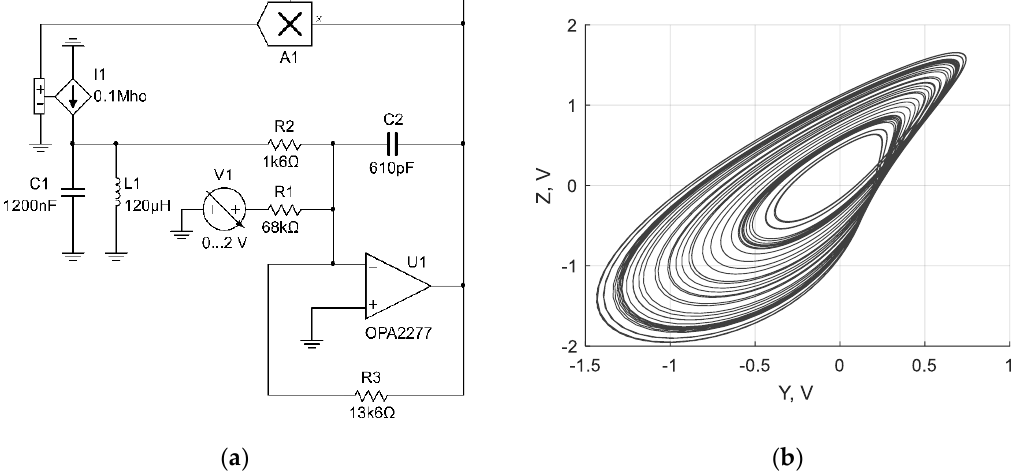
Figure 2. Chaotic circuit based on the Sprott Case N system with inductive element ( a ); corresponding attractor of the circuit ( b ).